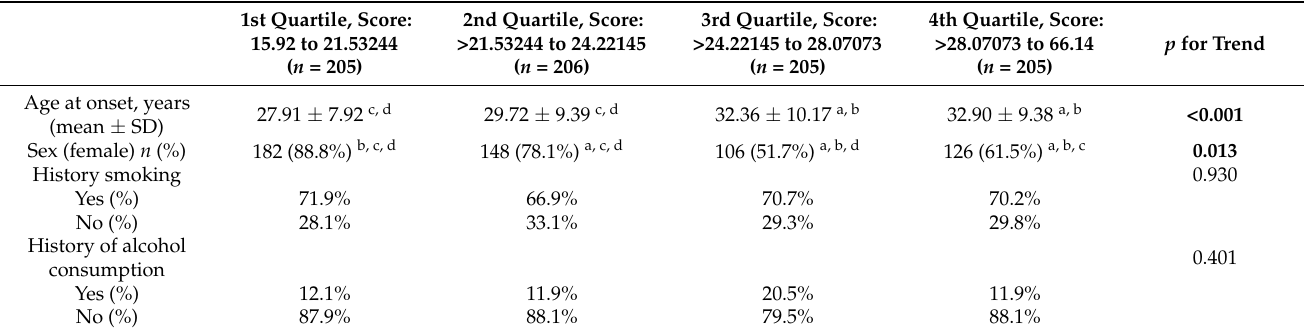
Table 2. Demographic characteristics of RRMS patients by quartiles of BMI.